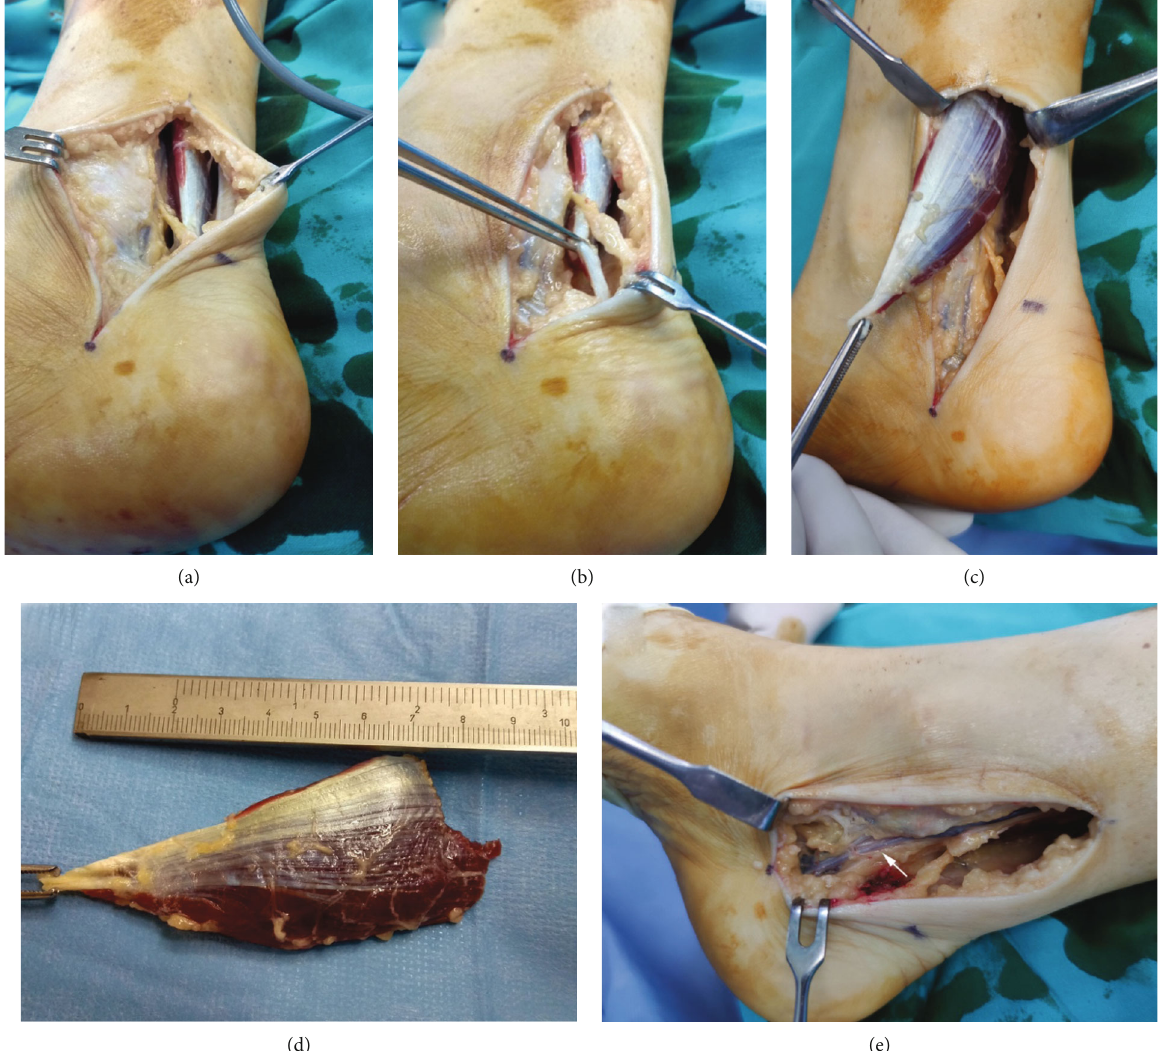
Figure 4: Intraoperative images of the patient presented in the second case. (a) Incision was made just medial to the Achilles tendon proximally and extended down to the proximal border of the tarsal tunnel. Accessory soleus muscle (ASM) is visible right below the skin and subcutaneous tissue. (b) ASM is elevated by a surgical pincer. Shrinkage of the muscle can be visualized towards its insertion. (c) ASM was bluntly dissected and separated from the surrounding structures. (d) The completely resected muscle that is approximately 8.5cm long. A tendinous distal part is marked by a surgical pincer. (e) Neurovascular bundle of the posteromedial part of the ankle is visualized after resection of ASM and the fl exor retinaculum. Neurovascular bundle is pointed by a white